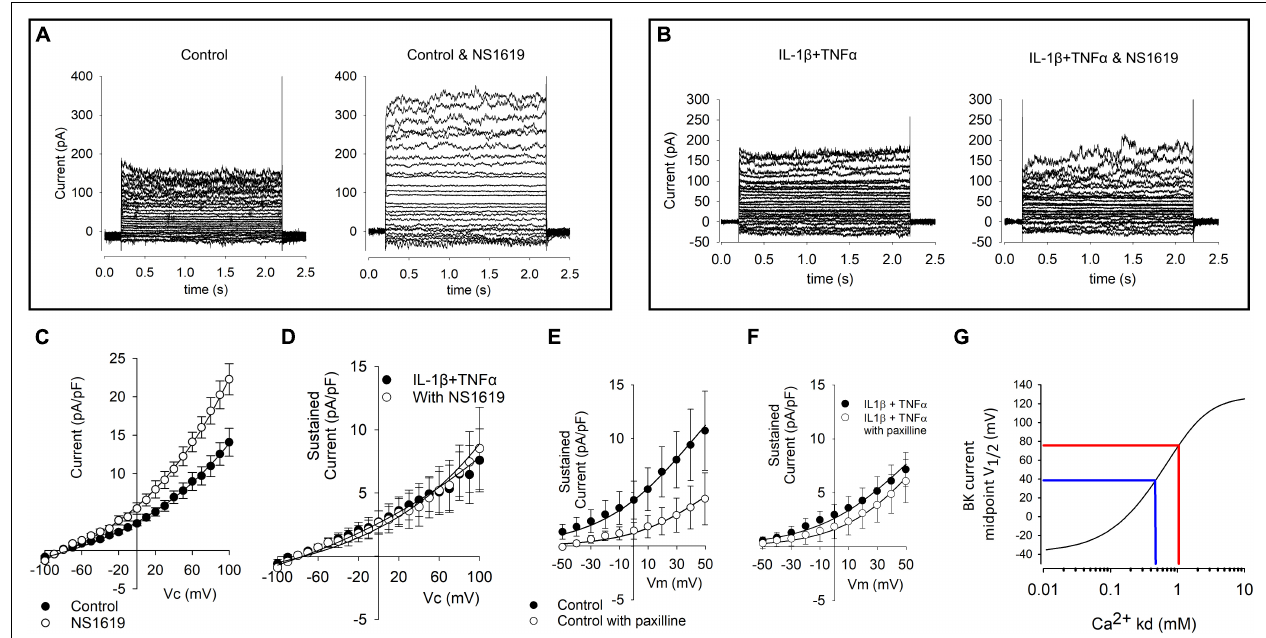
FIGURE 6 | Effects of BK channel drugs on FLS whole-cell currents. (A) Representative examples of untreated (control) cells before (left) and in the presence of 1 µ M of the BK channel opener NS1619 (left). Voltage protocols as shown in Figure 5. (B) Representative raw example current families of cytokine (10 ng/ml IL1 β + TNF α ) treated cells in the absence (left) and presence (right) of 1 µ M NS1619. (C) Current–voltage curves from a number of control FLS cells such as that shown in (A) . Current is significantly greater in the presence of NS1619, p < 0.05, n = 9 and 6. (D) Current–voltage curves for a number of treated FLS cells such as that shown in (B) . These two curves are not significantly different from each other n = 6 and 6. (E) Current–voltage curves from a number of control FLS cells treated with and without paxilline; there is a significant decrease in paxilline current p < 0.05 n = 13,5), but (F) there was no significant different of current density in the presence of the BK inhibitor paxilline following cytokine treatment ( n = 6, 12). (G) Numerical simulation of data from Clark et al. (2017) model . To quantify the degree of change of BK channel modulation apparently taking place with this treatment we used the model of verbatim with the exception that we varied the inherent BK channel Ca 2 + sensitivity parameter Kd . In this simulation, the independent variable Kd is plotted on the x -axis and the predicted BK current midpoint (V 1 / 2 ) is plotted on the y -axis. In blue, we have added hypothetical midpoints of 40 mV and 80 mV representing a hypothetical shift in 40 mV by cytokine treatment. The complete MATLAB code for this simulation is included in the Supplementary File S1